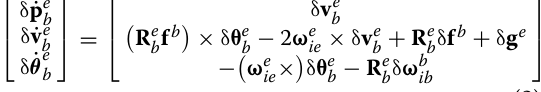
Process model The linearized continuous dynamic INS model (Shin, 2005) can be written